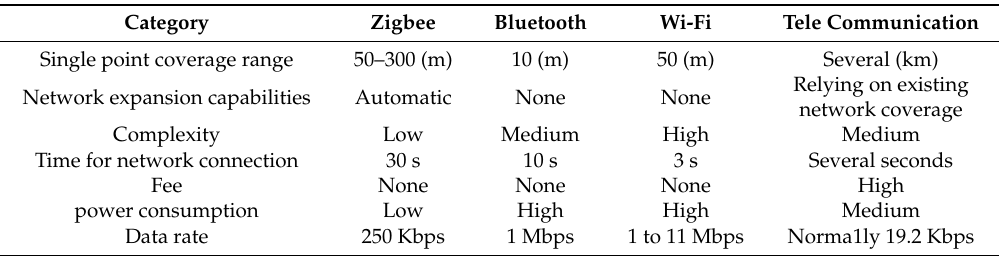
Table 1. Comparison of several wireless network